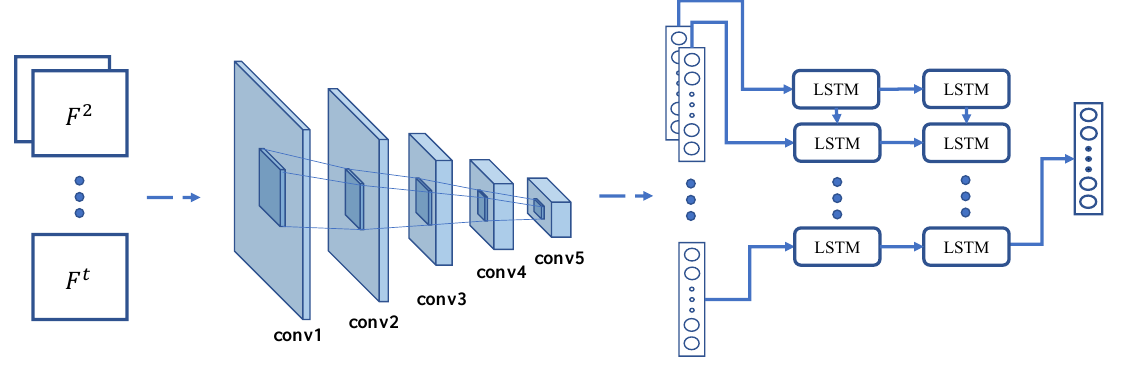
Figure 3. The feature extraction network for